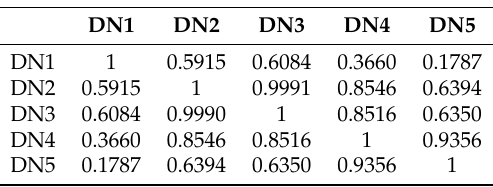
Table 8. R 2 values for 500 bin histograms for iPerf TCP IATs for the traces from five Dell Netbooks cleaned using Th = 0.1.